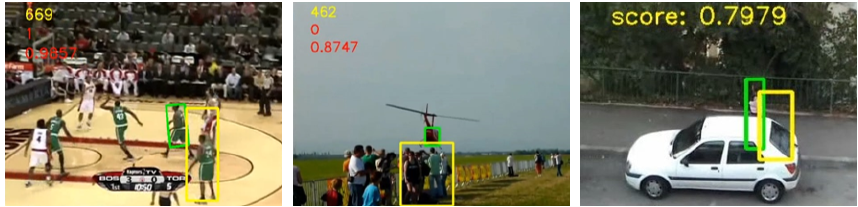
Figure 5. Failure cases. Video instances of Basketball, Helicopter and Woman on VOT-2018 [9] and OTB2015 [10]. They represent multiple foreground images similar to the target, severe out-of-view and sudden background clutter